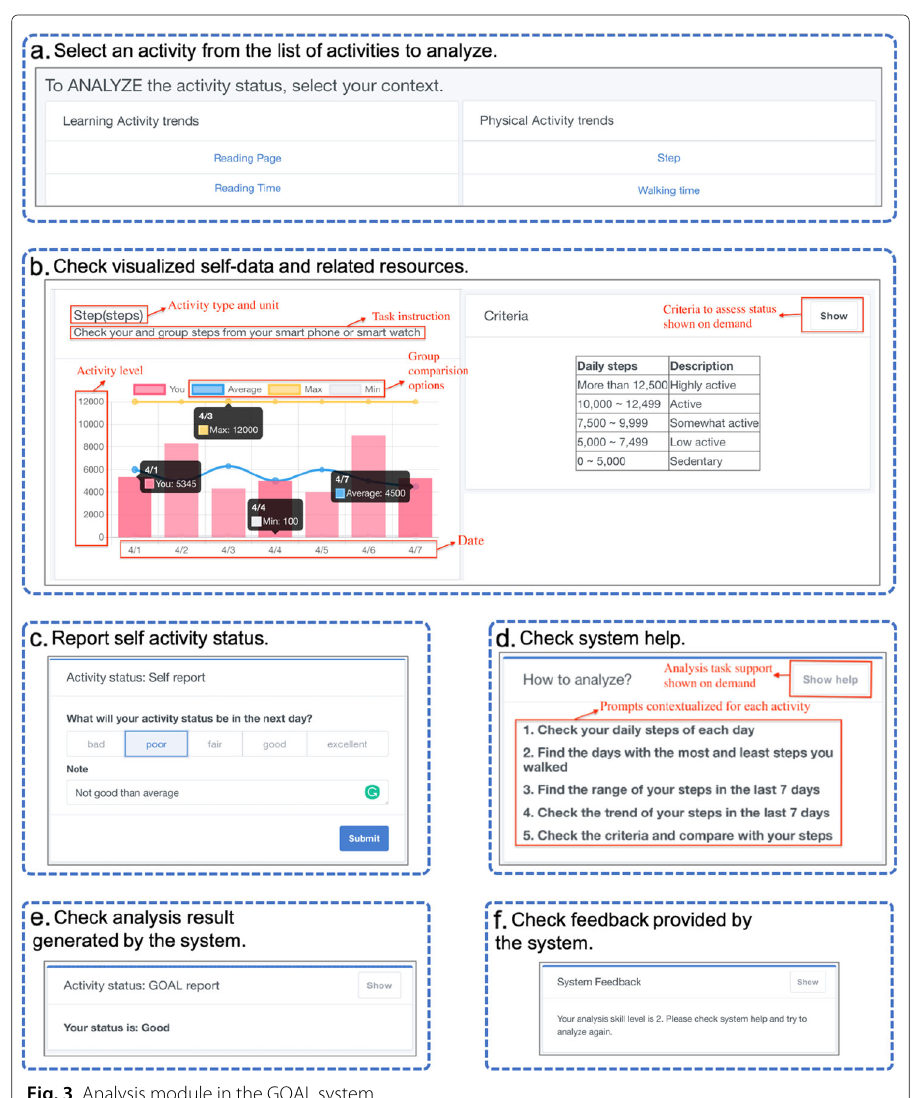
Fig. 3 Analysis module in the GOAL